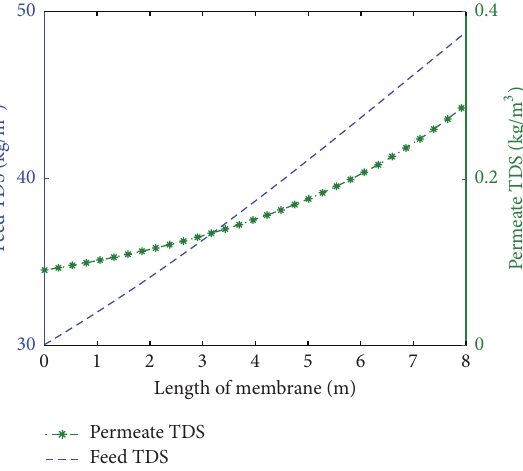
Figure 8: Permeate flux along the length of membrane.